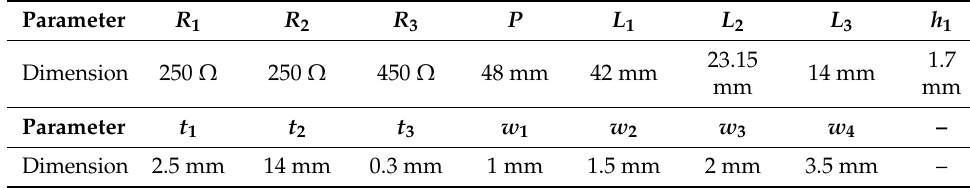
Table 1. Optimized dimensions of the unit